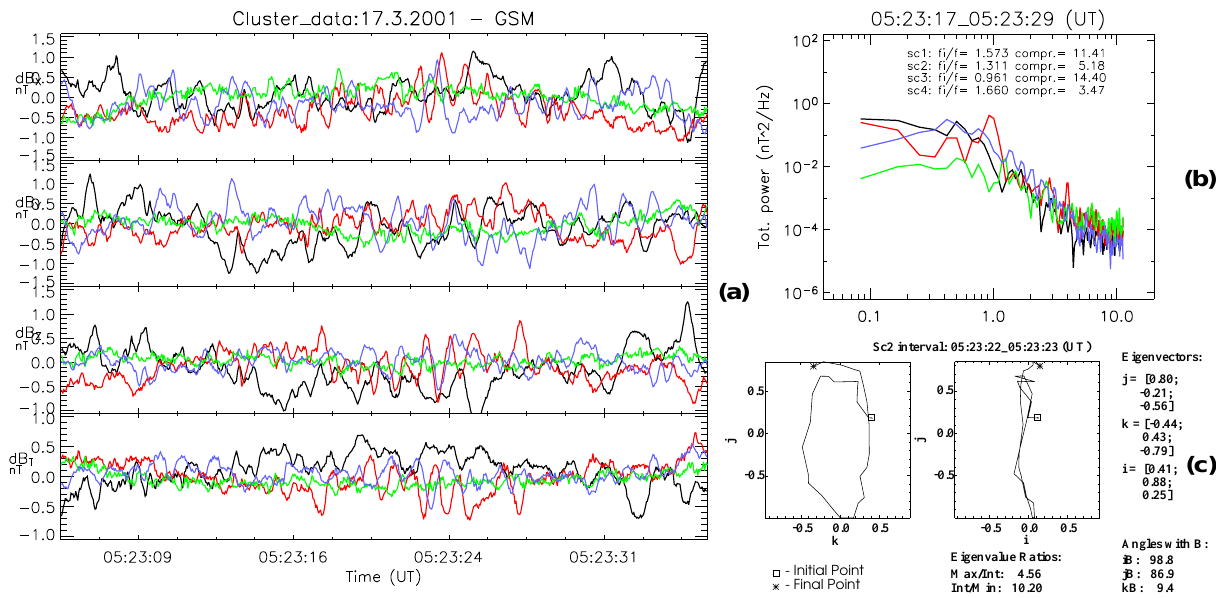
Fig. 8. (a) De-trended magnetic field components between 05:22:50–05:23:42 UT for all Cluster spacecraft (left). On right-hand side are total power in fluctuations (top) to the magnetic field at 05:23:17–05:23:29 UT for all 4 spacecraft. Hodogram of the wave magnetic field between 05:23:22–05:23:23 UT observed by SC2 is plotted on panel (c) . and ellipticities between